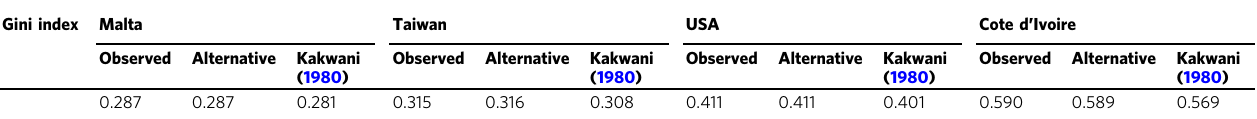
Table 10 The comparison of the estimated values of the Gini index between the alternative functional form that is based on the weighted average of the exponential function and the functional form implied by Pareto distribution and the Kakwani (1980) ’ s functional